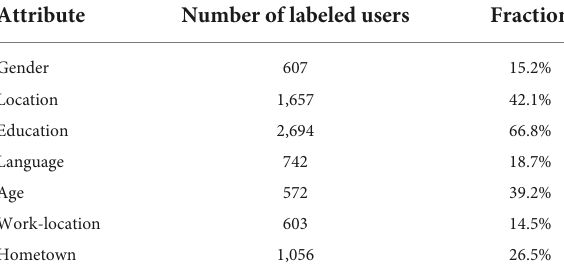
TABLE 5 Completeness of each attribute information in the Facebook data